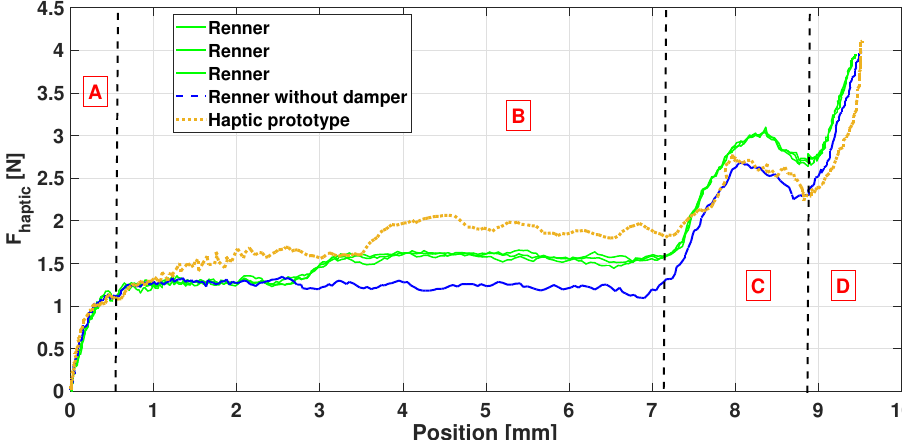
Figure 24. Haptic piano key force validation: prototype comparison with the Renner ® demonstrator (results confirming those obtained in [30]).